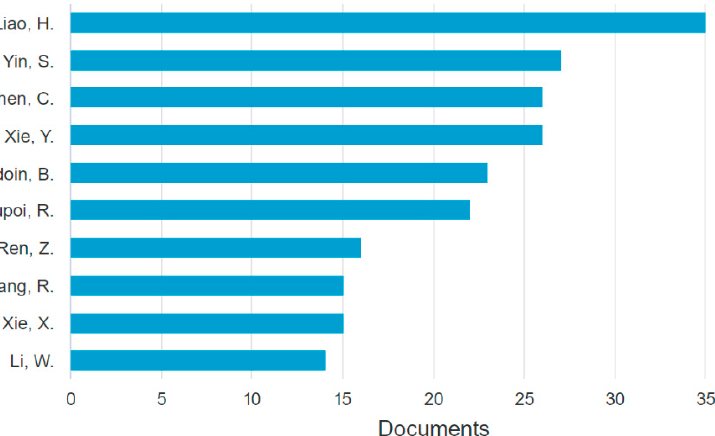
Figure 15. Number of documents per author.